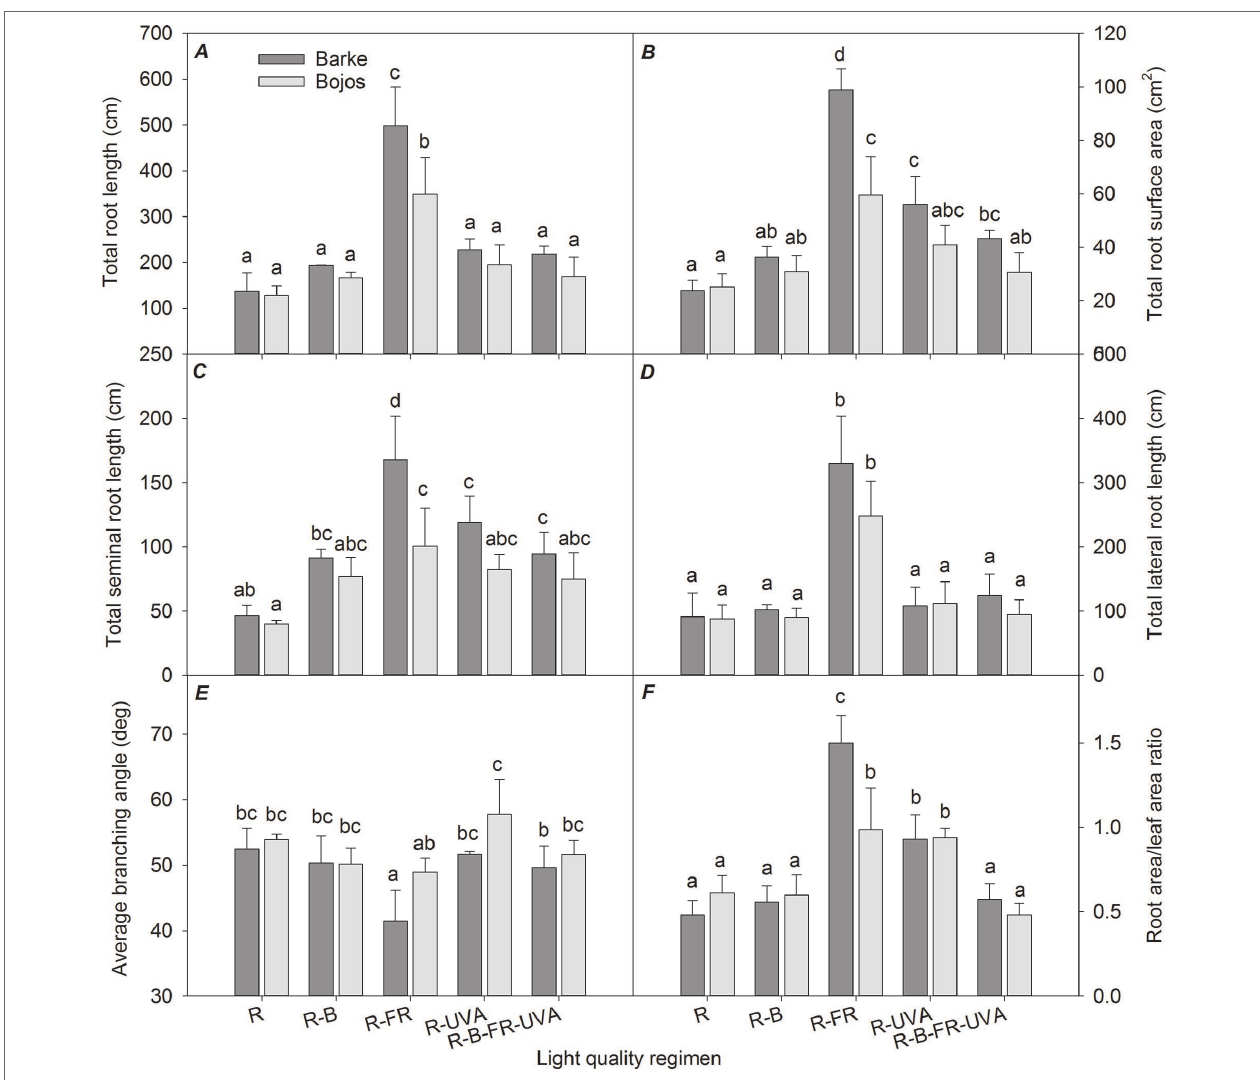
FIGURE 2 | Effect of 26 days exposure to different light regimens on total root length (A) , total root surface area (B) , total seminal root length (C) , total lateral root length (D) , average branching angle (E) , and ratio of total root area:total leaf area (F) of spring barley varieties Barke (dark grey) and Bojos (light grey). Additional details are in the Figure 1